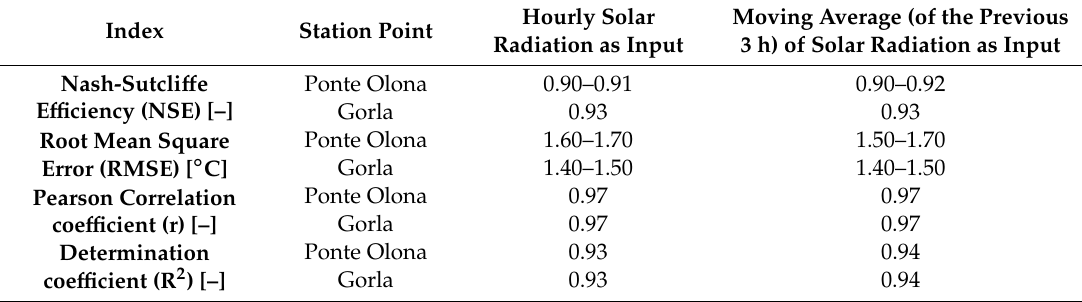
Table 6. Statistical indexes during cloudy days between observed and simulated LST values by the MEC algorithm using the hourly solar radiation and the 3 h-moving average as input.